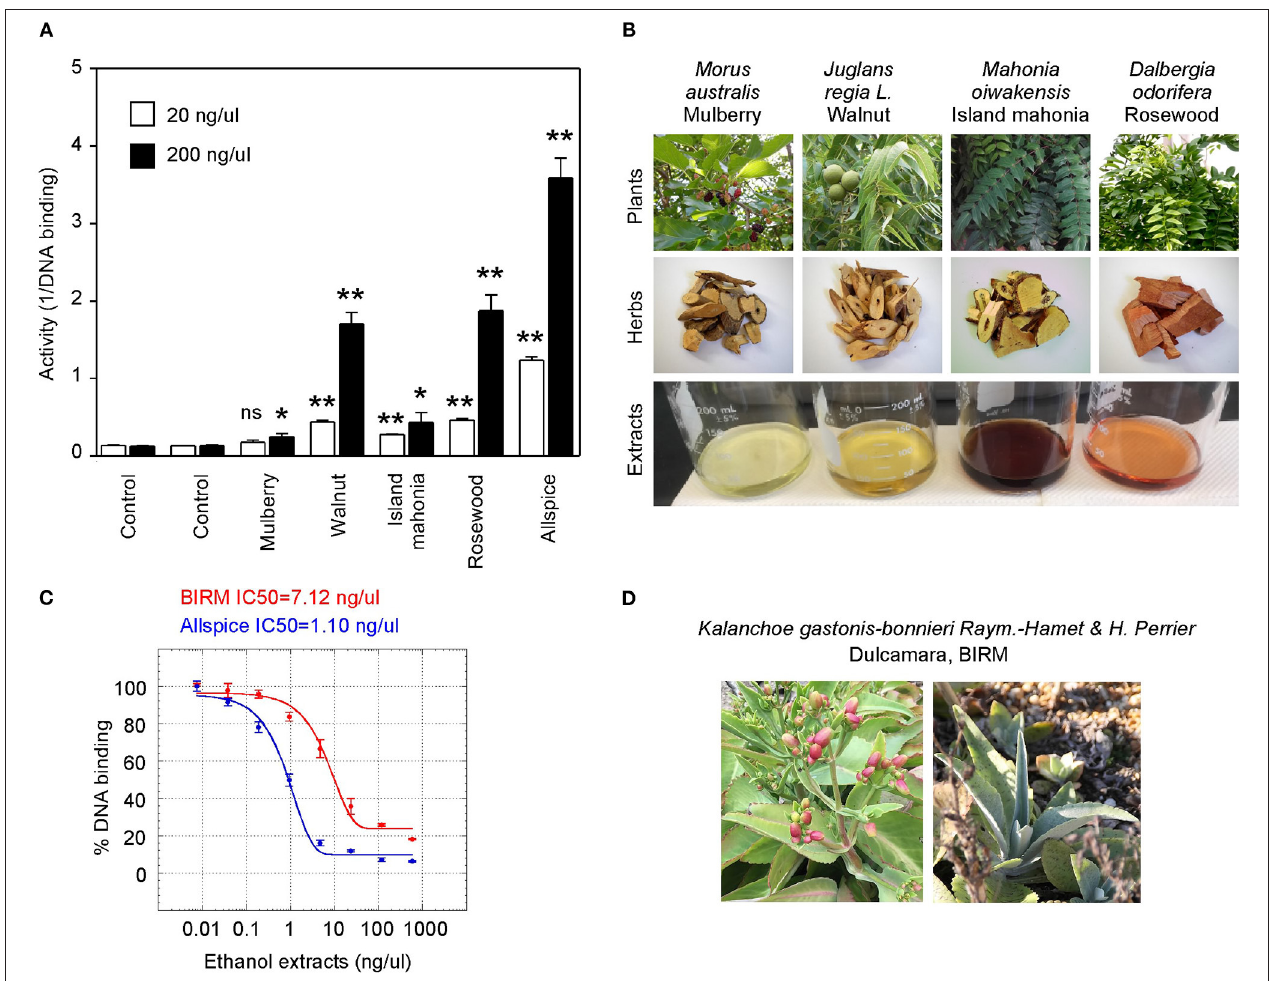
FIGURE 6 | Commercial herbal medicines inhibit GT198. (A) Ethanol extracts from four tree branches inhibit the DNA-binding of GT198. The four trees are mulberry, walnut, island mahonia, and rosewood from a Taiwanese anticancer remedy. Allspice is a positive control. (B) Photographs of the four plants, their corresponding herbs, and ethanol extracts assayed in panel A. (C) BIRM, an Ecuador product of dulcamara root extract, inhibits the DNA-binding activity of GT198. Allspice as a positive control. IC 50 s are indicated. (D) Photographs of dulcamara plant. * P < 0.05 and ** P <